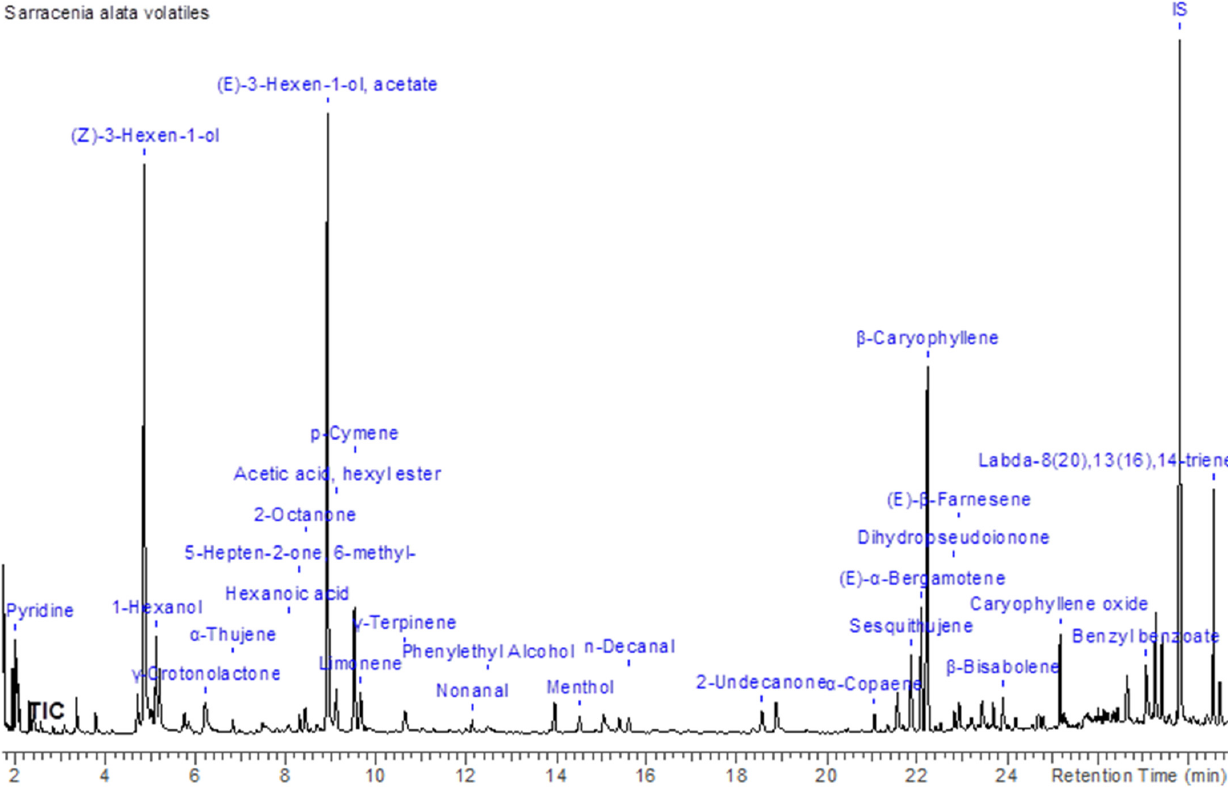
Figure 2. The volatile organic constituents’ profile of Sarracenia alata microcuttings.